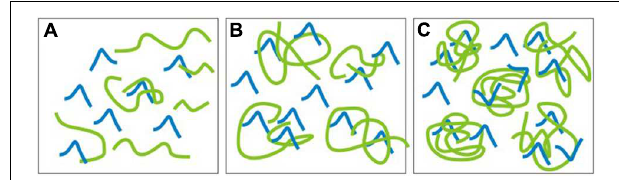
FIGURE 2 | Scheme of the possibility of siloxanes short chains trapping in the bundles of longer chains: (A) Viscosity < 10 000 cSt, small chains entanglement; (B) Viscosity 60 000 cSt, moderate chains entanglement, (C) Viscosity 30 000 000 cSt high chains entanglement.